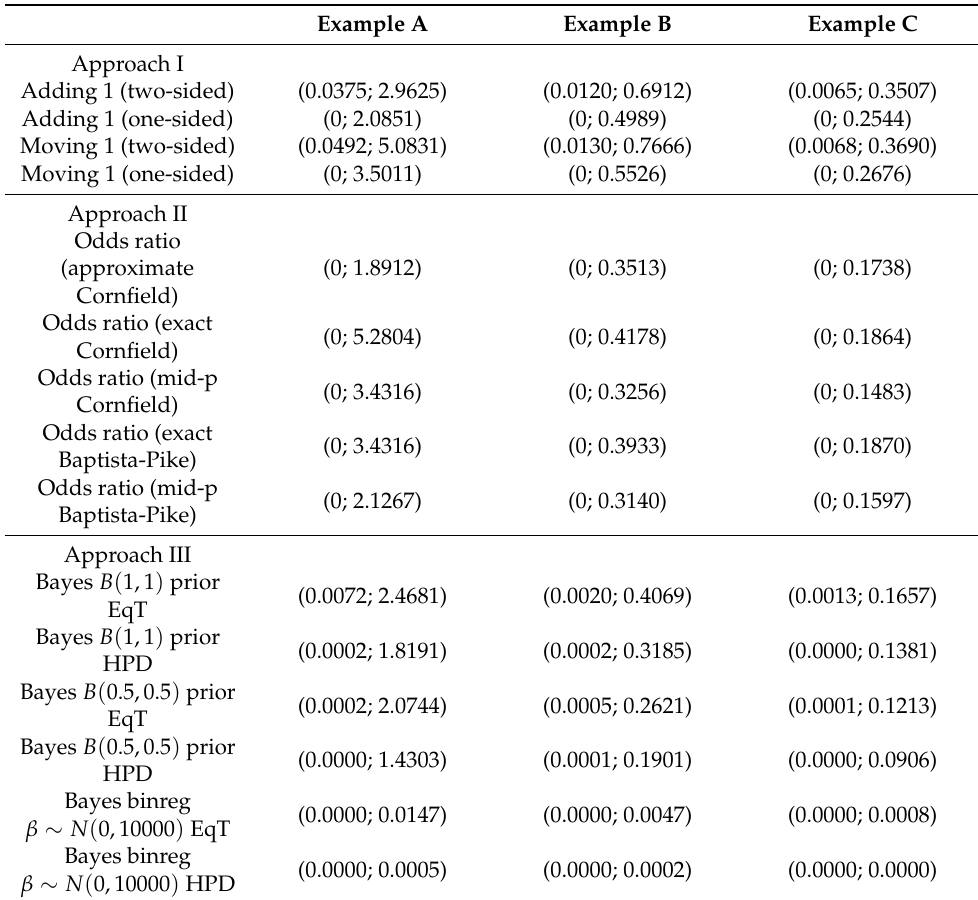
Table 2. Results: reported intervals are 95% CIs for frequentist methods and 95% CrI for Bayesian methods. (Note: 0 indicates an estimate formally forced to be 0, while 0.000 indicates an estimate numerically within 0.0005 of